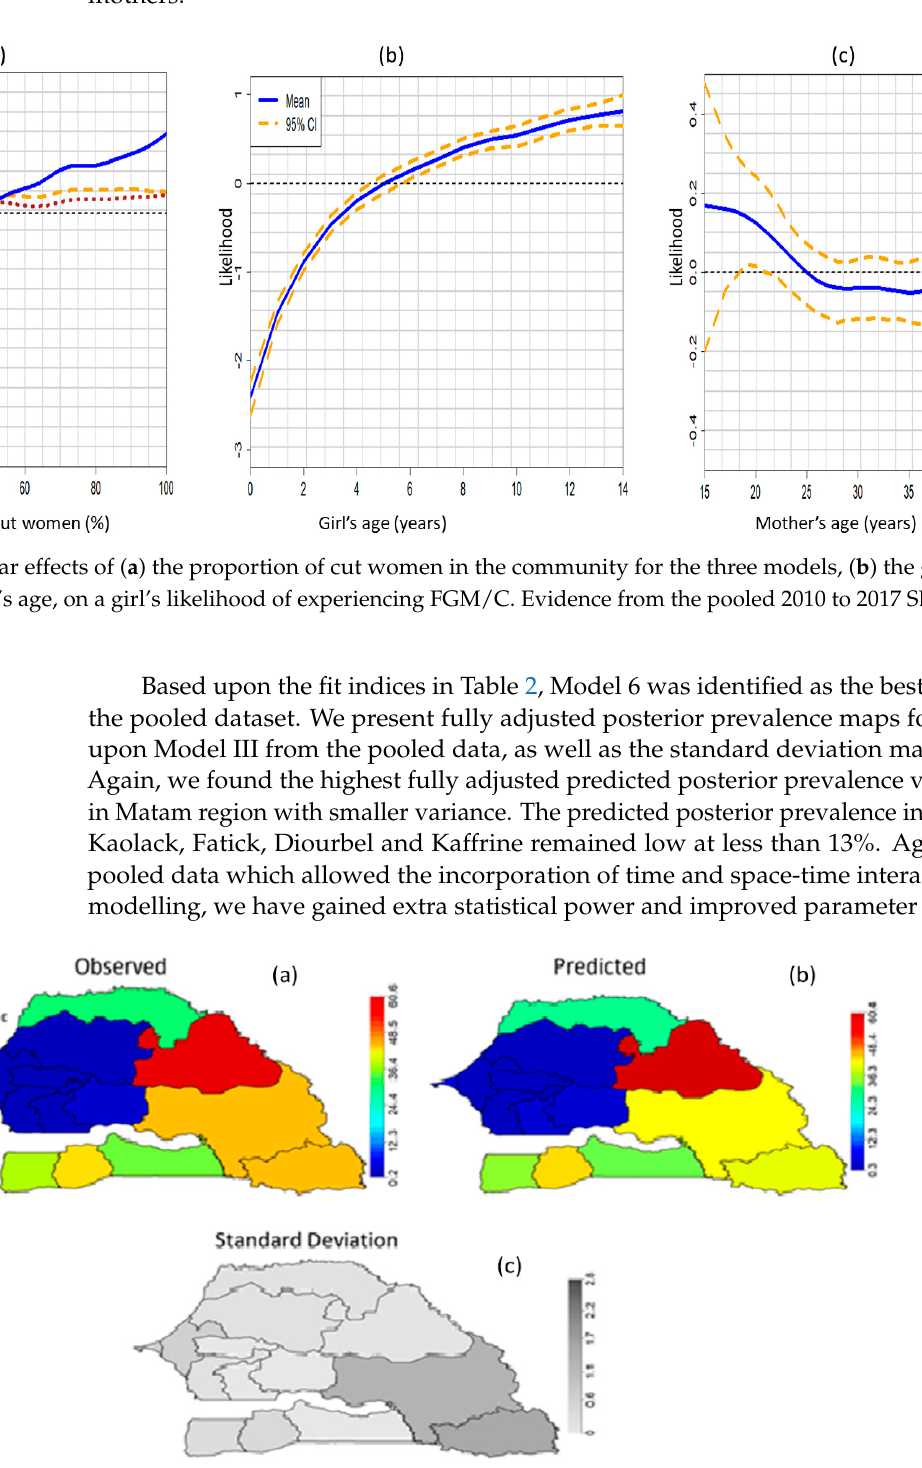
Figure 8. Observed prevalence ( a ), predicted posterior prevalence ( b ), and posterior standard de- 0–14 year old girls’ FGM/C. Deep blue to red corresponds to low to high prevalence. Light to dark grey colours correspond viation ( c ) of Senegalese 0–14 year old girls’ FGM/C. Deep blue to red corresponds to low to high to increase in uncertainty of estimation. Evidence from the pooled 2010 to 2017 SDHS (Model prevalence. Light to dark grey colours correspond to increase in uncertainty of estimation. Evi- dence from the pooled 2010 to 2017 SDHS (Model 6).